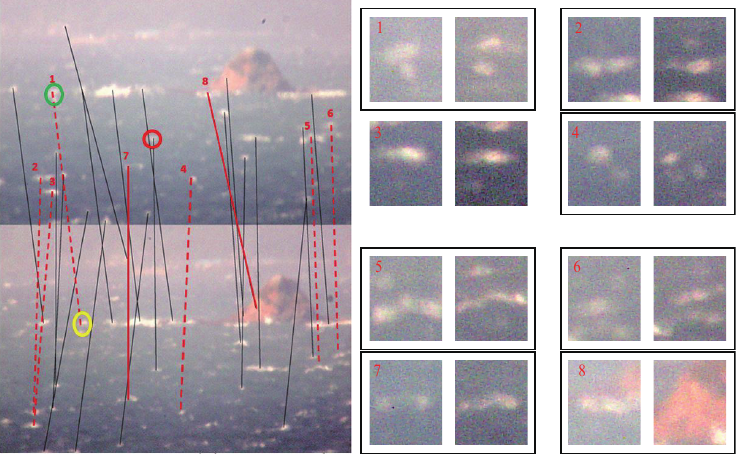
Figure 8. Matching result of Euclidean distance between feature vectors. The left image shows the matching result, the black solid lines represent true positive matches (correct matches and detected by the matching method), red solid lines represent false positive matches (incorrect matches but detected by the matching method), and red dotted lines represent false negative matches (correct matches but not detected by the matching method). The right 8 images are the enlarged images of sea wave pairs which belong to false positive and false negative